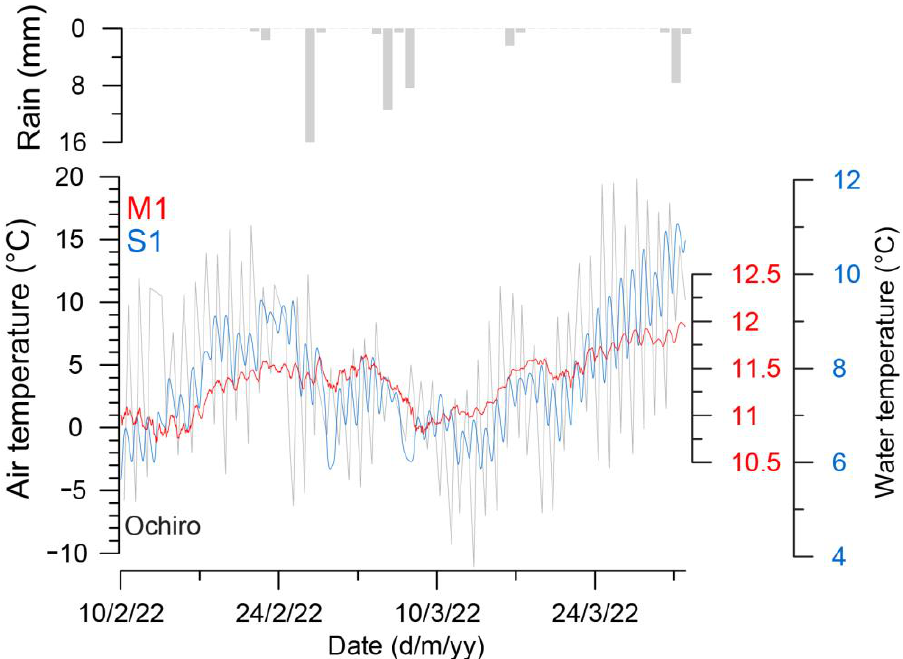
Figure 8. Diurnal temperature fluctuations in station S1 and M1 in February and March 2022. Note that the temperature scales are different for the three curves.